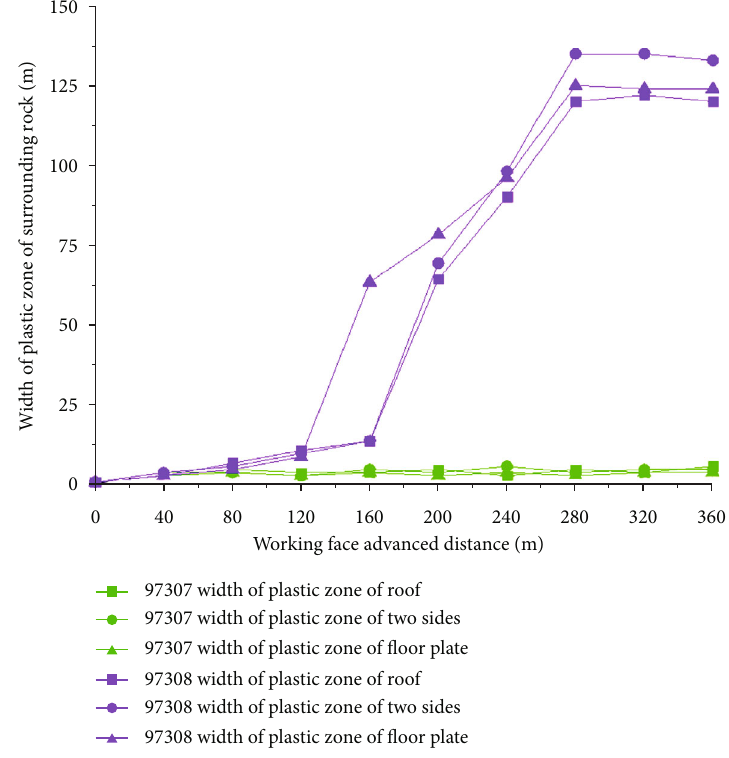
Figure 13: Changes of plastic zone width of roadway during mining of 9# coal